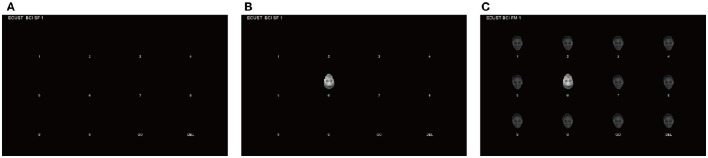
The interface that was shown to the participants. (A) The matrix without stimuli. (B) An example of the stimulus in the IF-pattern. (C) An example of the stimulus in the MIF-pattern. The feedback appeared at the top of the screen during online sessions.